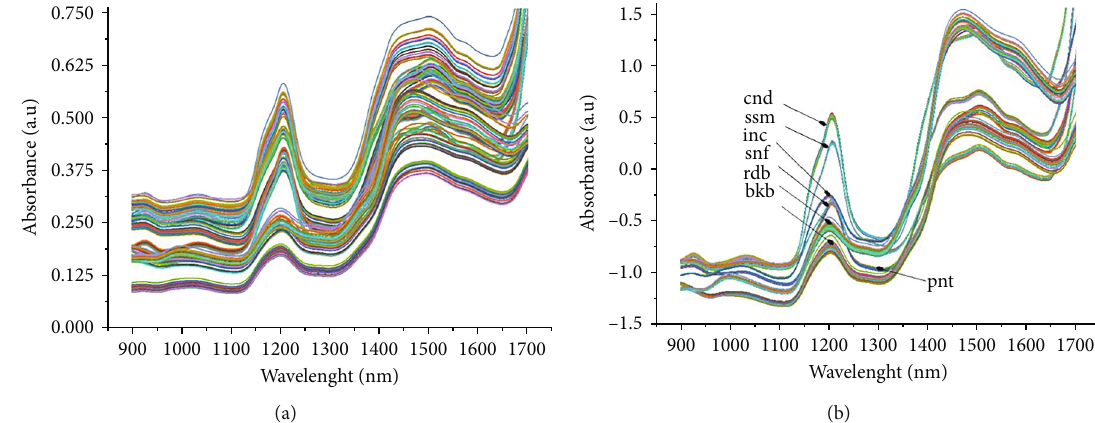
Figure 2: Smoothing spectra by Savitsky-Golay (a) and SNV pretreatment spectra (b) of candlenut (cnd), peanut (pnt), sesame (ssm),